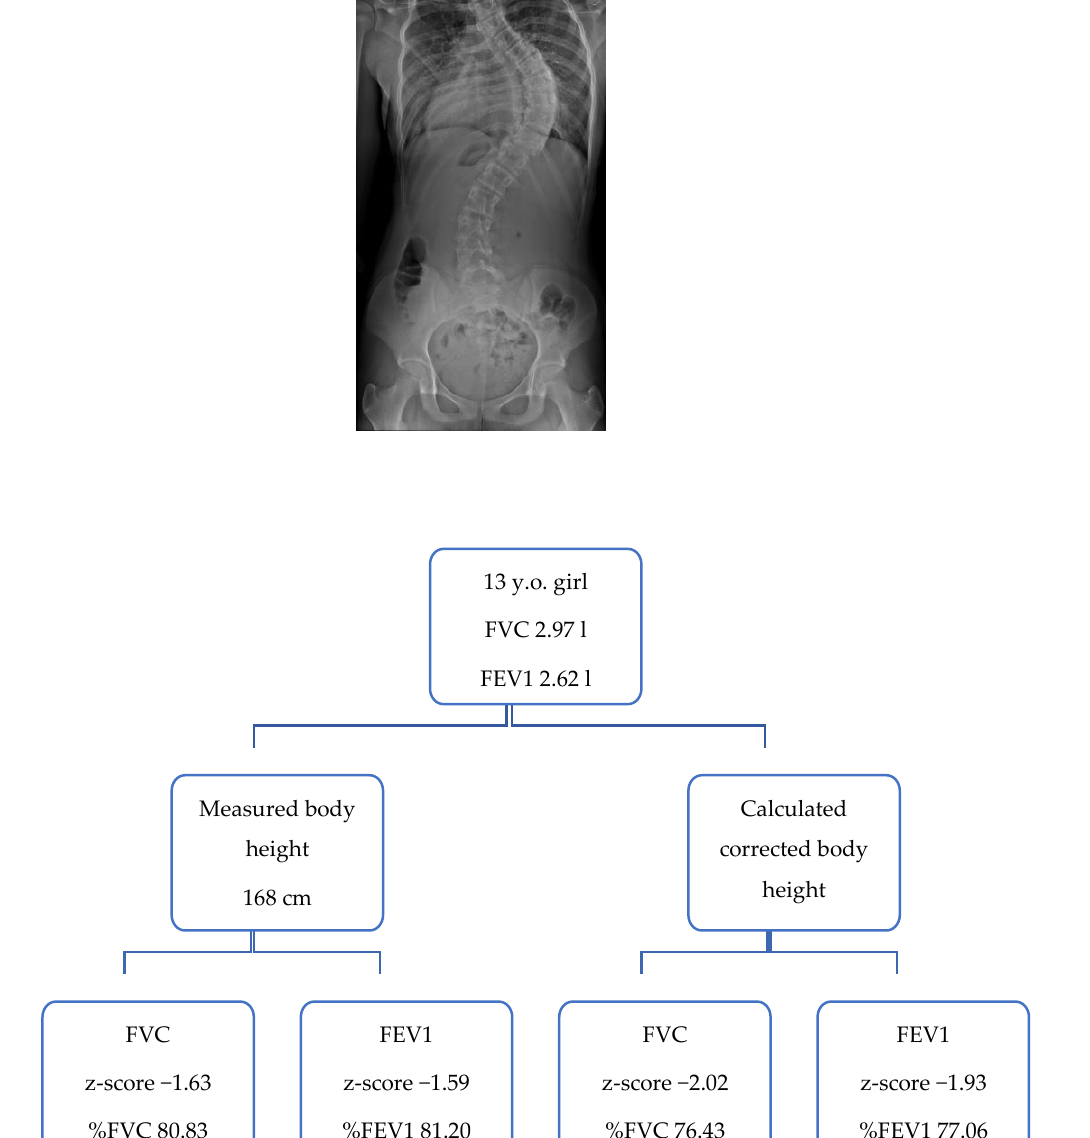
Figure A1. Example of a patient presenting a discrepancy in the interpretation of spirometry testing. A case of a 13-year-old girl with right idiopathic thoracic scoliosis, Cobb angle 70°. The pulmonary parameters are within the norm when the normal values are calculated for the measured body height. The parameters suggest a mild impairment of pulmonary function when calculated using the corrected body height.